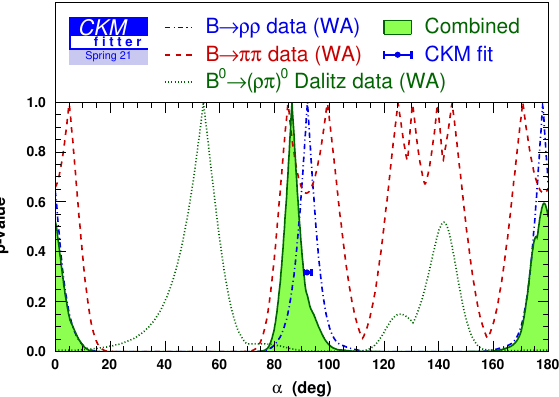
Figure 11 . Isospin triangles for B → ππ ( B 0 , B + modes on the left-hand side, the right-hand side) based on the current world average [39, 77].